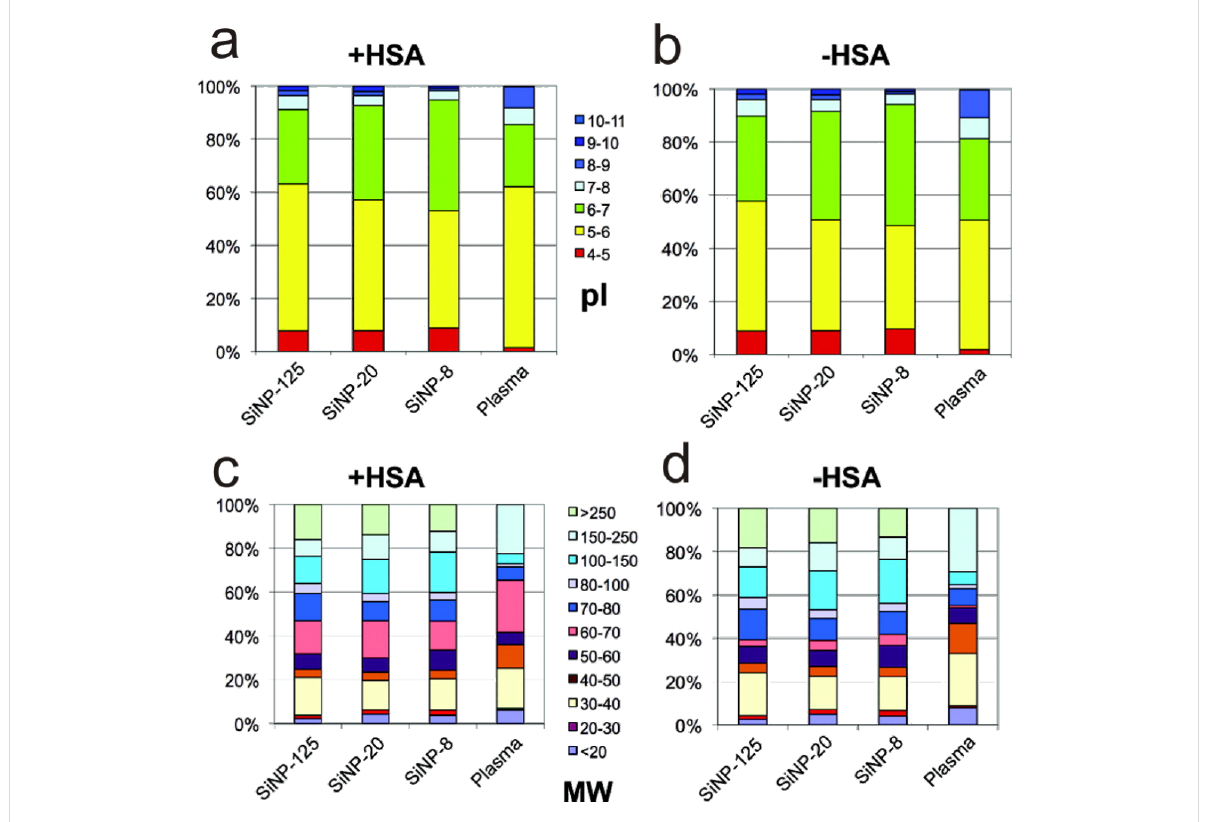
Figure 5: Composition of protein coronae around SiNPs of different sizes as identified by quantitative mass spectrometry by Tenzer et al. [8]. Proteins were classified by (a,b) their isoelectric points (pI) as calculated from the sequence information and by molecular weight (MW) (c,d). (a,b): SiNPs pref- erentially bound negatively charged proteins (pI < 7) at pH 7.3. Proteins with pI < 5 were enhanced in the protein corona, independent of the particle size, as compared with plasma. (c,d) Proteins with low molecular mass were found to be less abundant in the corona than in plasma, while large proteins were significantly enriched in the corona. The observed patterns remained unchanged when the most abundant plasma protein, human serum albumin (b,d: − HSA), was excluded from the data analysis. Reprinted with permission from [8]. Copyright 2014 American Chemical